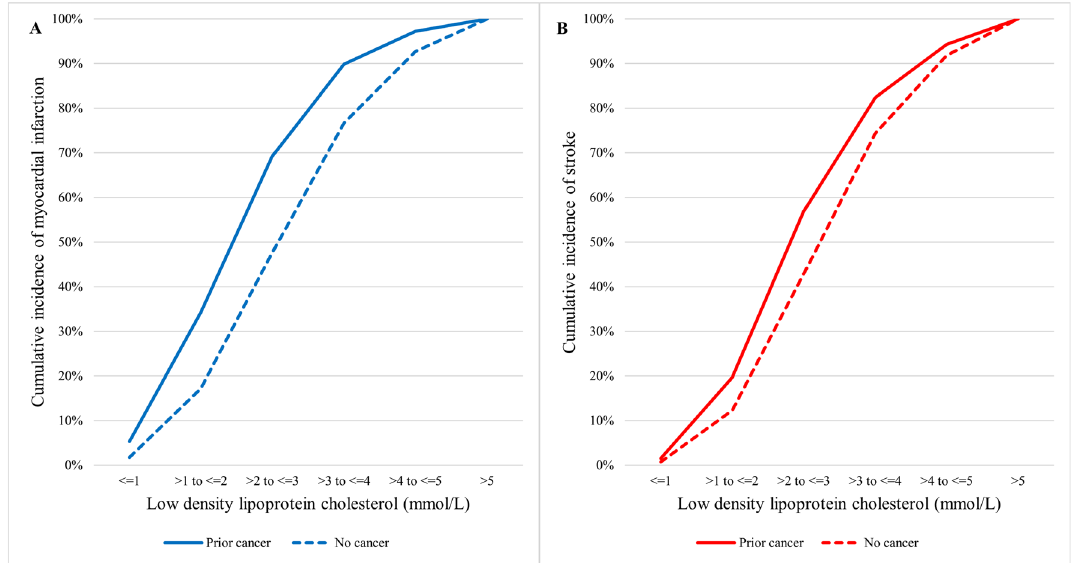
Figure 2. Cumulative incidence of myocardial infarction ( A ) and stroke ( B ) in relation to LDL-C by cancer status. The solid lines represent the prior cancer group whilst the dotted lines represent the no cancer group. LDL-C: low density lipoprotein